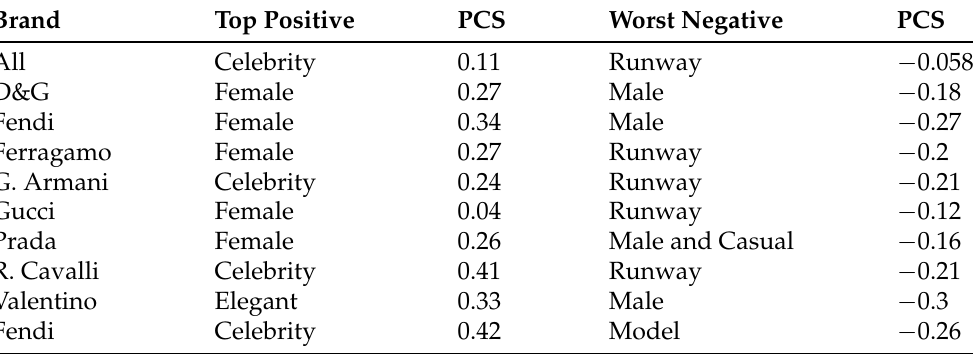
Table 2. Most correlated features with the engagement rate (both positive and negative) for each brand considering all together obtained from Pearson correlation score (PCS).